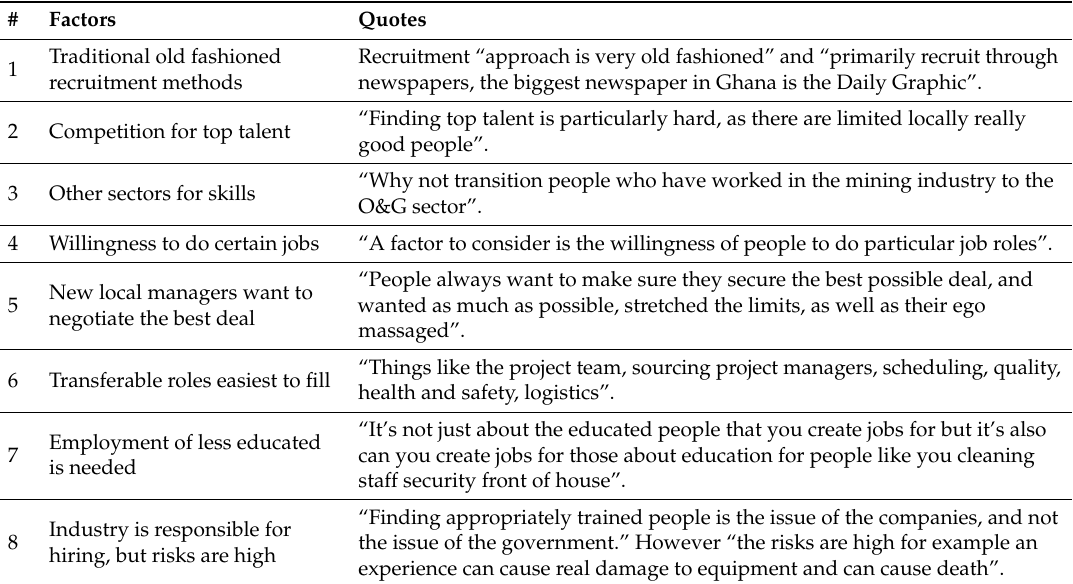
Table 16. ‘Local hiring in Ghana’